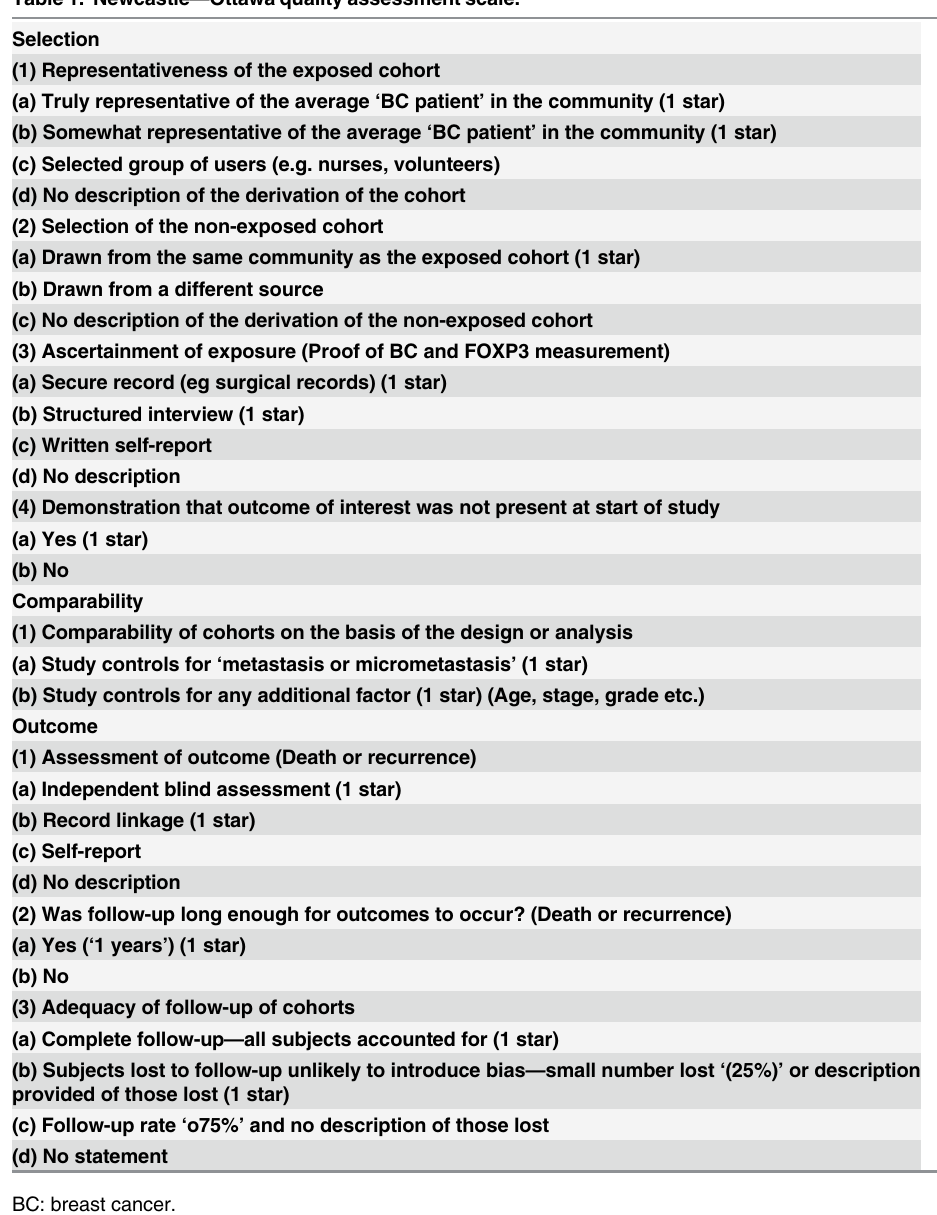
Table 1. Newcastle — Ottawa quality assessment